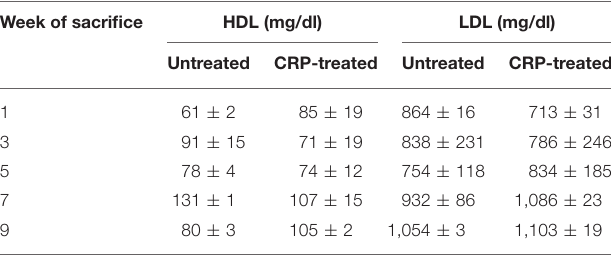
Frontiers in Immunology |